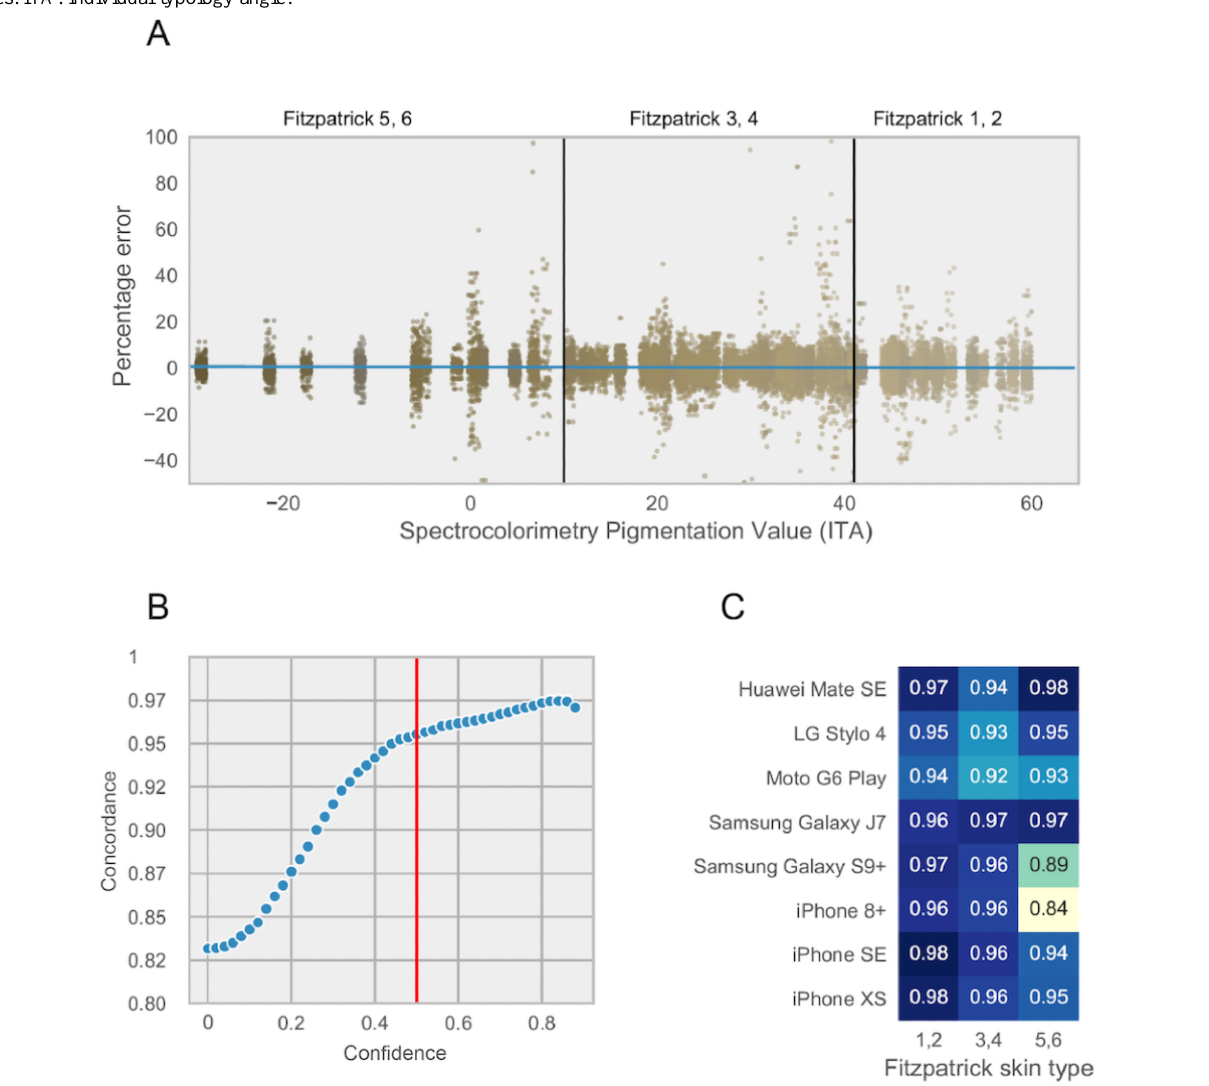
Figure 3. Validation of heart rate measurements across different skin tones and hardware configurations in the calibration study. (A) Percent error in heart rate estimation from ground truth as a function of different colors captured by spectrocolorimetry under the jaw. Each dot represents a 10 second window of heart rate in one individual. (B) Distribution of concordance between heart rate using pulse oximetry and smartphone as the confidence cutoff is changed. Red line represents the chosen cutoff used for analysis. (C) Concordance as a function of smartphone models and Fitzpatrick skin tones. ITA: individual typology